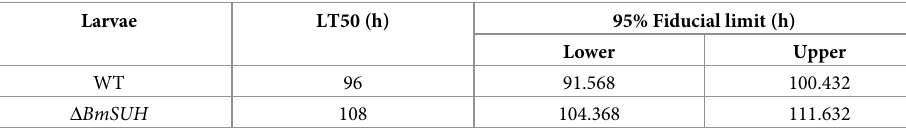
Table 2. LT50 of fourth instar larvae after oral